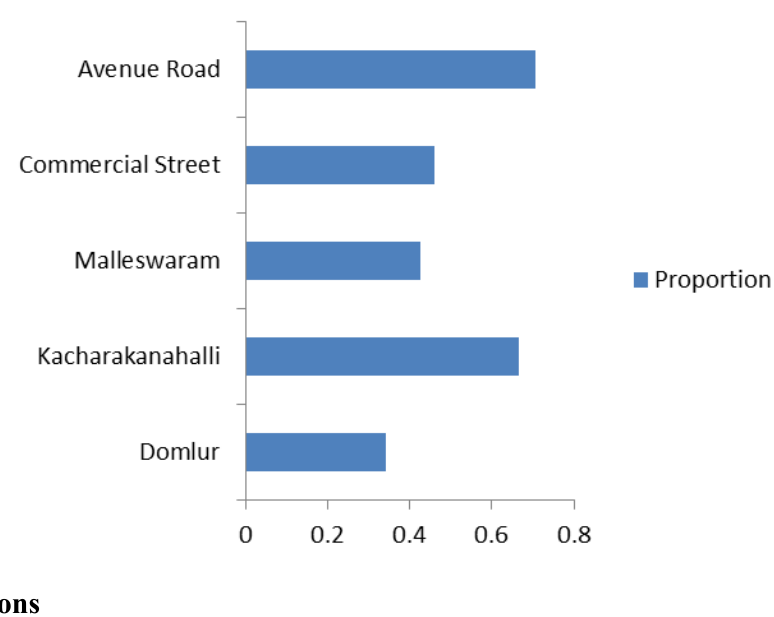
Figure 14. Percentage of endemic trees in the five study locations in Bangalore, based on field